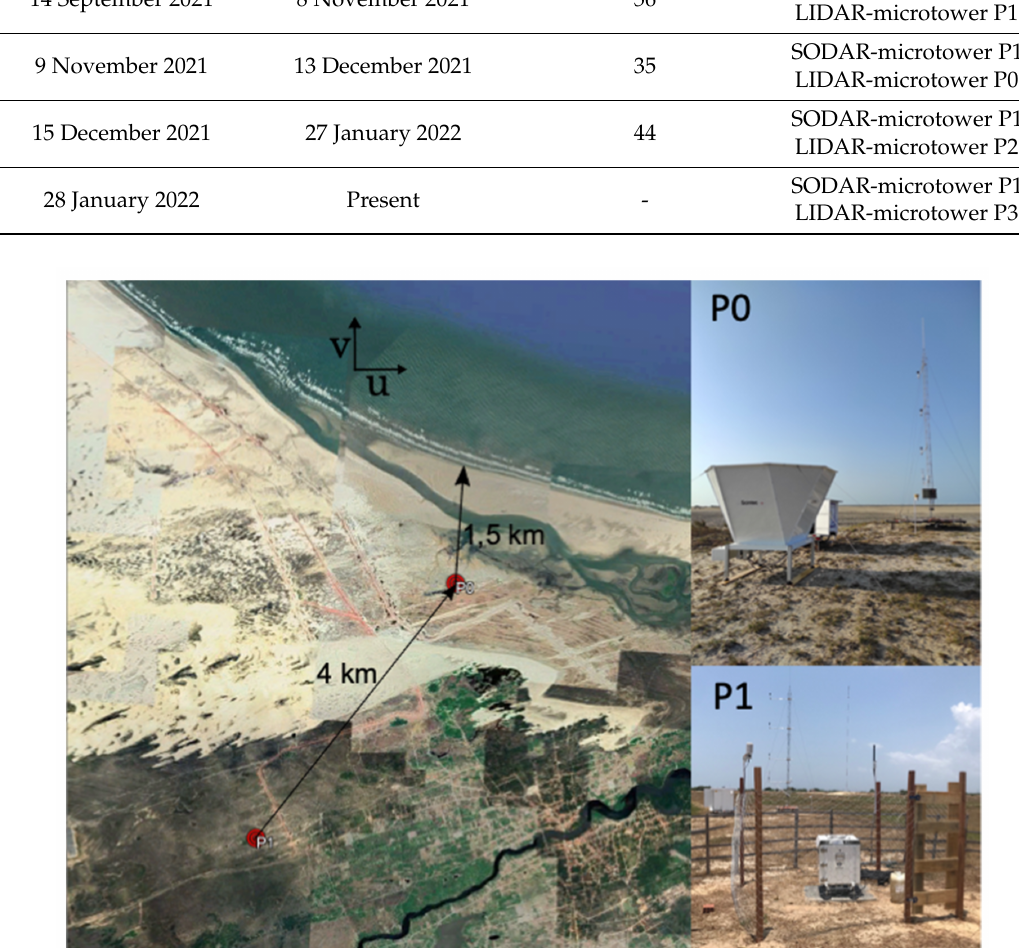
Figure 5. Google Earth image showing the location of P0 and P1 sites for data